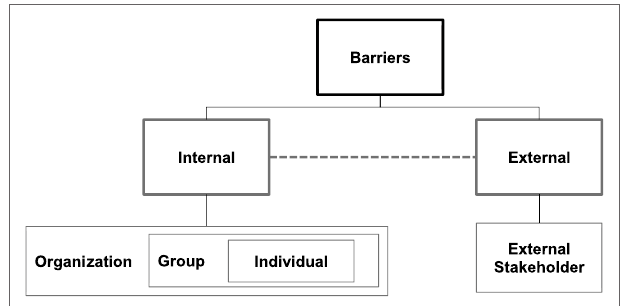
FigUre 1 | Applied barrier framework (adapted from Hueske and Guenther,